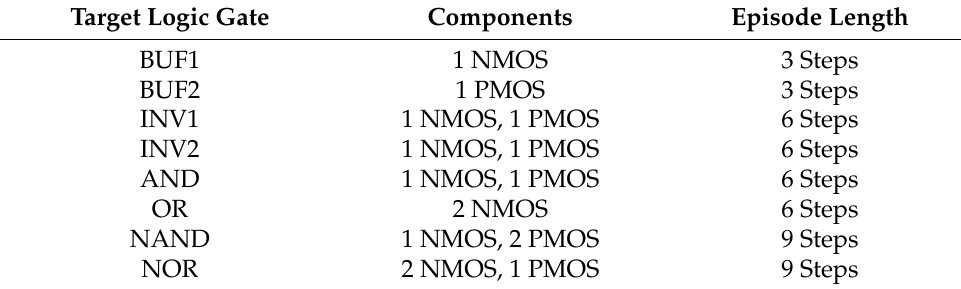
Table 1. Training results for target logic